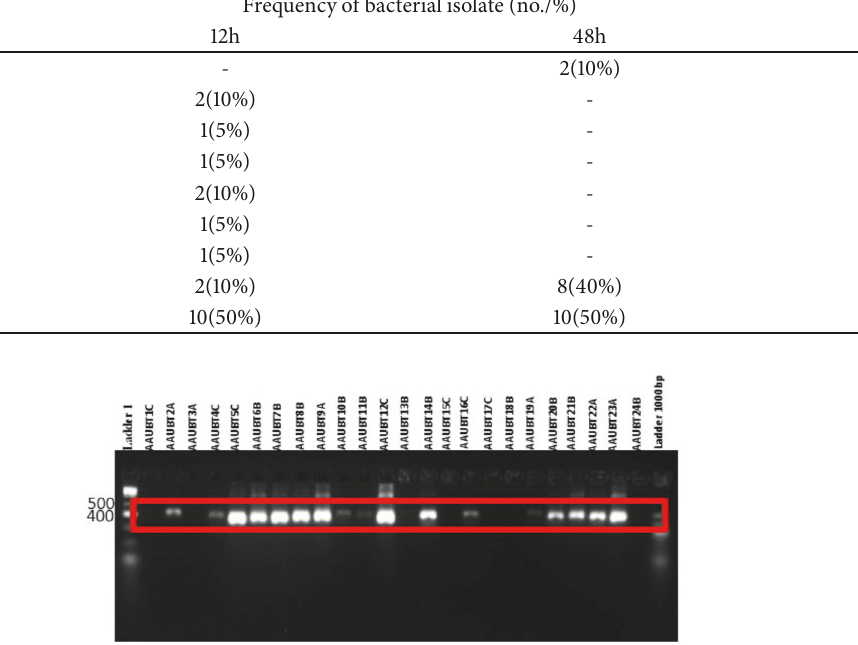
Figure 2: PCR amplification 16s rRNA using rD1 and fD1 bacterial universal